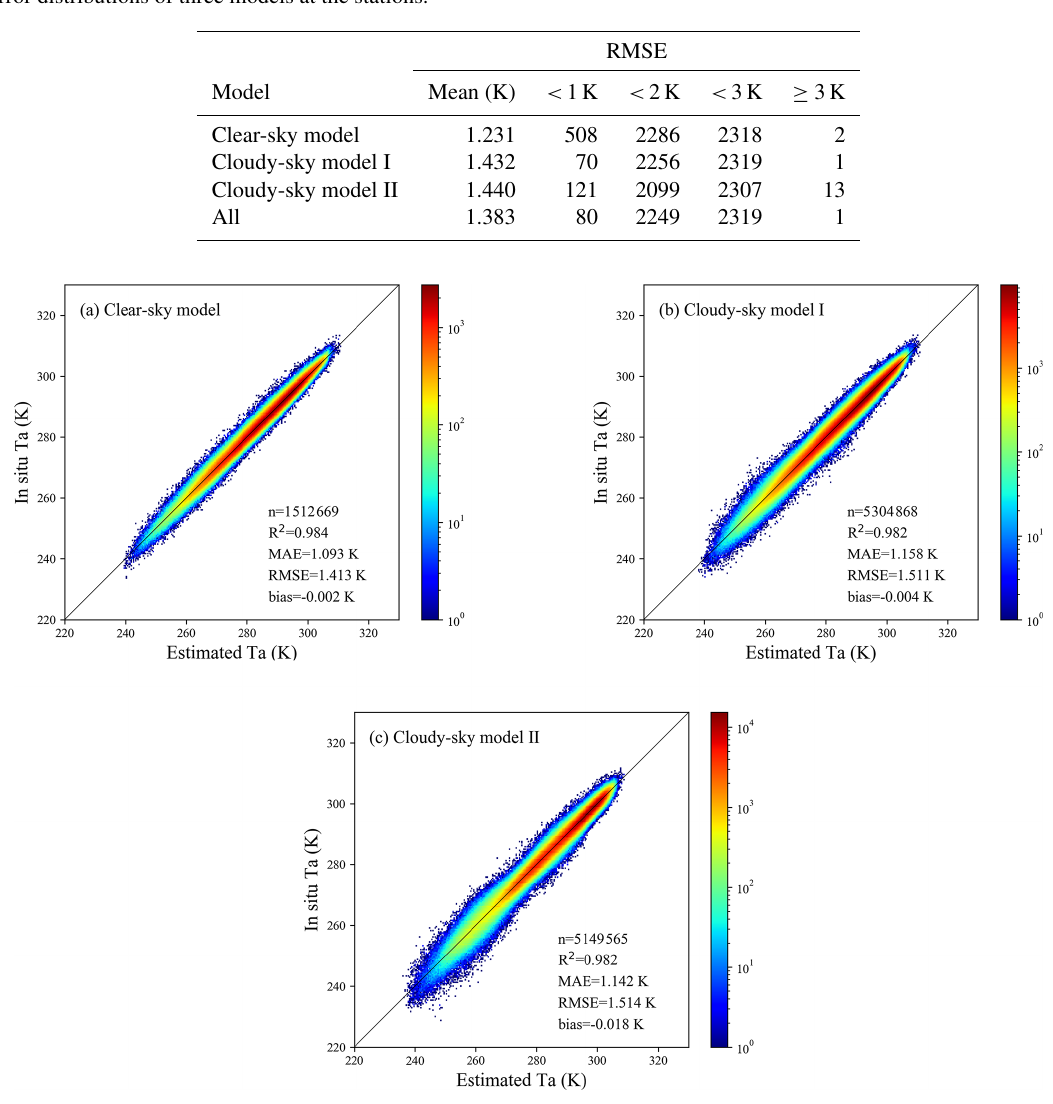
Table 5. Error distributions of three models at the stations.